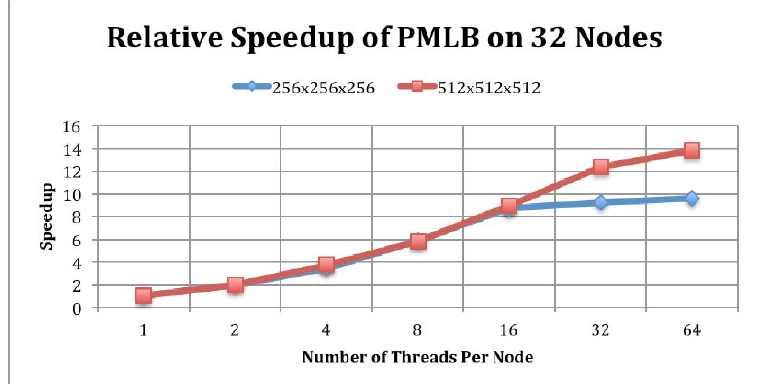
Figure 10. Performance comparison of PMLB on 32 Nodes with different number of threads per